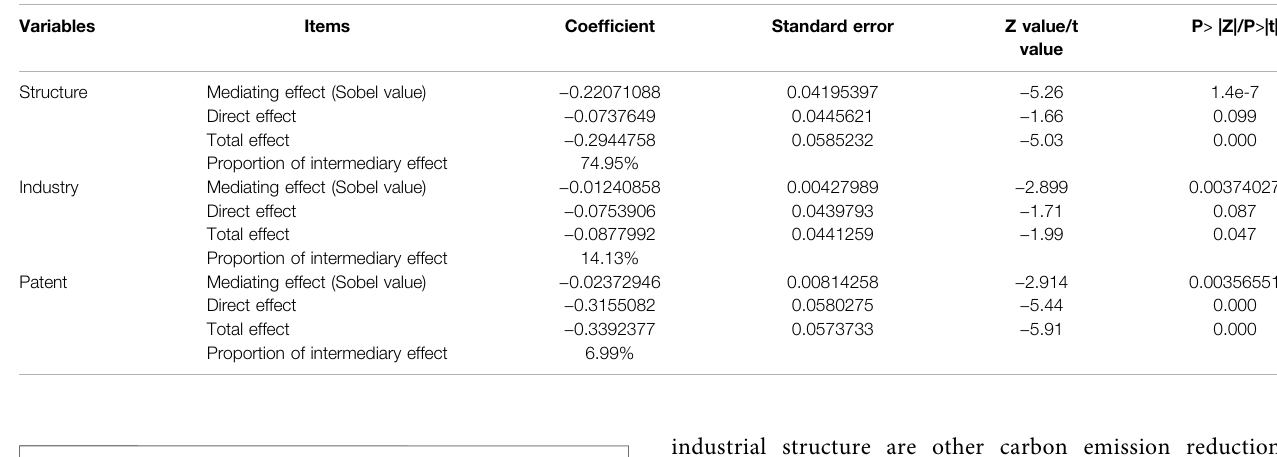
TABLE 6 | Sobel test results.